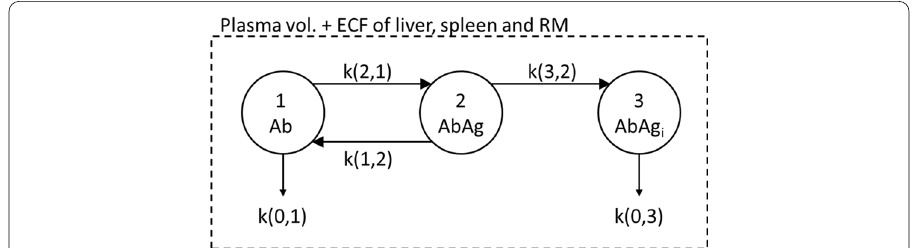
Fig. 2 Pharmacokinetic model for radiolabeled antibody. The dotted line corresponds to the distribution volume of IV-administered antibody; ECF extracellular fluid volume. Compartments 1 and 2 represent the = free, (Ab) and antigen-bound antibody (AbAg) states, respectively. Compartment 3 represents internalized AbAg. The figure is adapted from reference